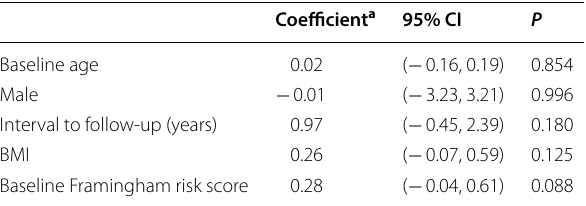
Table 4 General linear model for factors associated with change in QRS duration